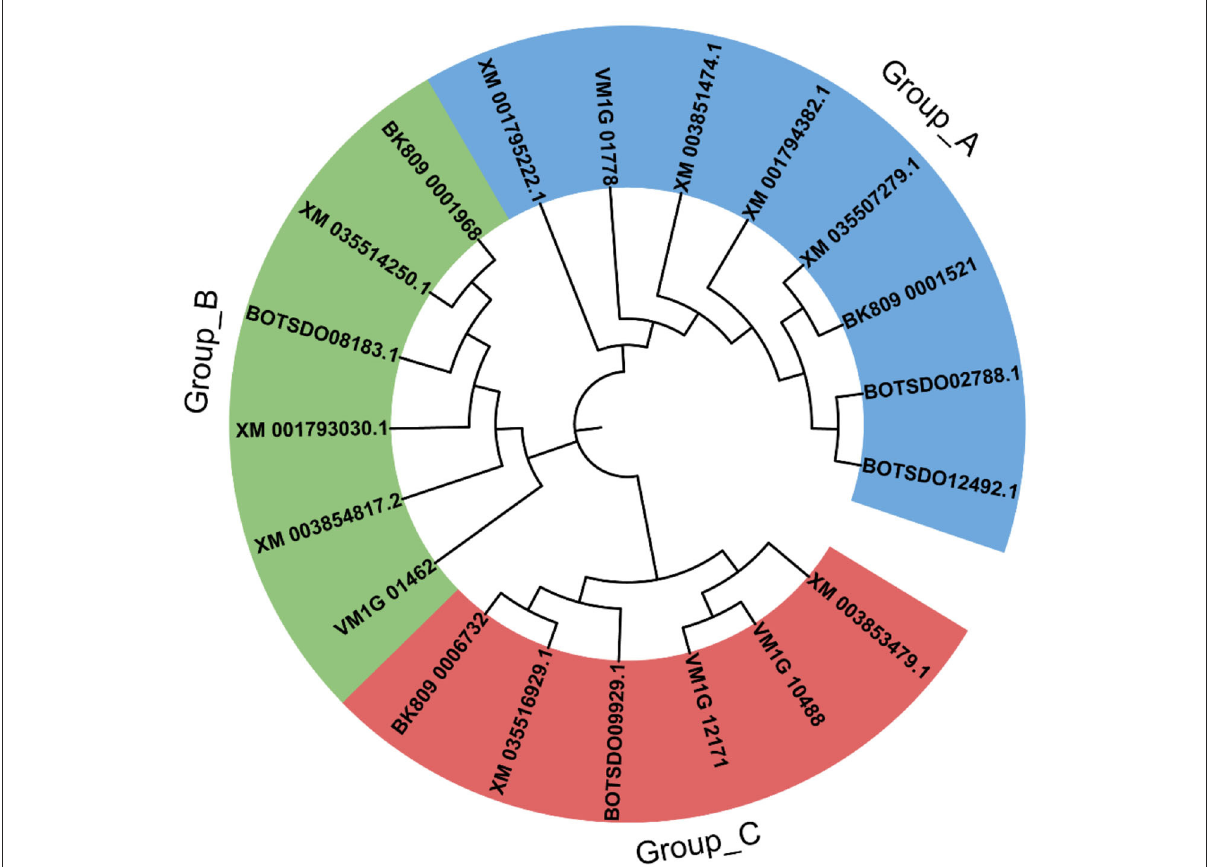
FIGURE2 Phylogenetic tree constructed by the Hsp20 gene family of the six species, including Botryosphaeria dothidea (BdHsp20_2, BdHsp20_1, BdHsp20_3, BdHsp20_4), Diplodia seriata (BK809_0001521, BK809_0001968, BK809_0006732), Lasiodiplodia theobromae (XM_035507279.1, XM_035514250.1, XM_035516929.1), Parastagonospora nodorum (XM_001794382.1, XM_001795222.1, XM_001793030.1), Zymoseptoria tritici (XM_003851474.1, XM_003854817.2, XM_003853479.1), and Valsa mali (VM1G_10488, VM1G_01462, VM1G_12171,